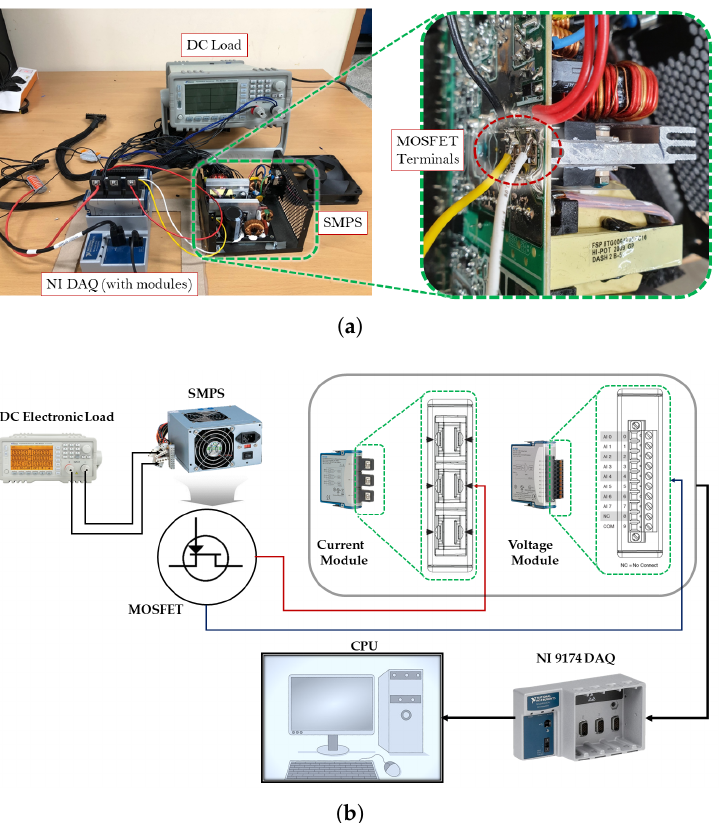
Figure 4. Experimental setup ( a ) a photo of the actual experimental setup, ( b ) an illustration of the data acquisition